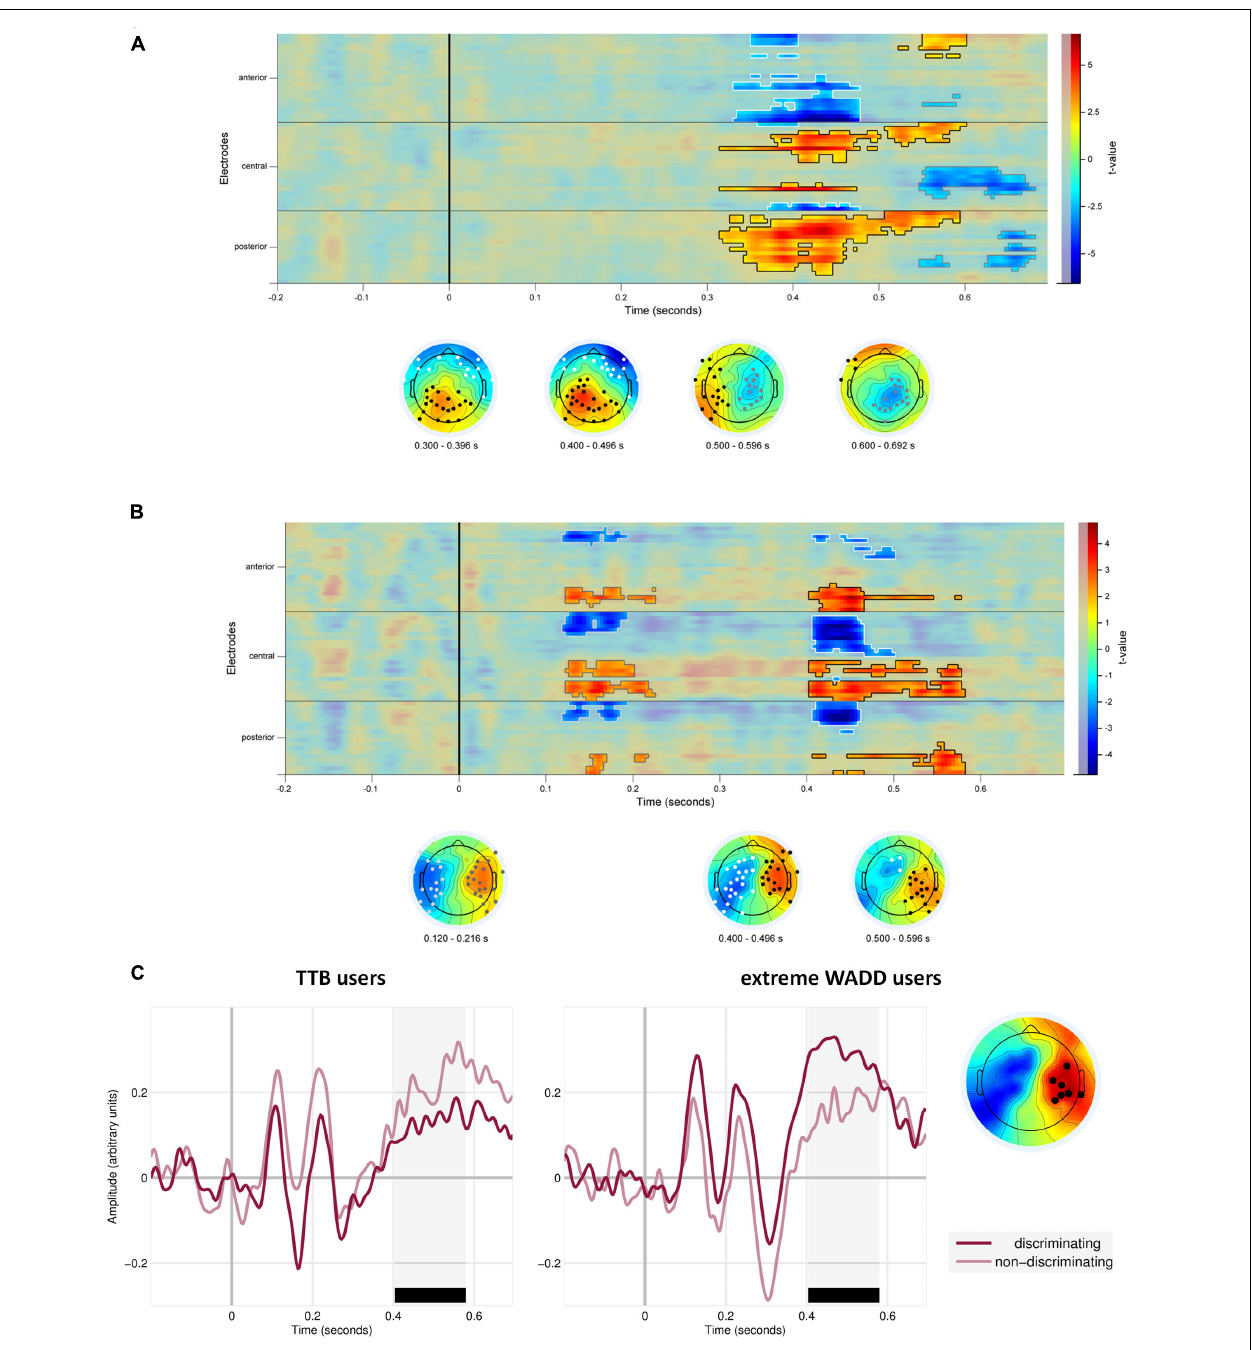
FIGURE 5 | (A) Temporal and scalp distribution of the main effect of cue discrimination. Marked in black, white and gray are the spatiotemporal clusters where the EEG amplitude differed for the discriminating and non-discriminating cue. (B) Temporal and scalp distribution of the interaction effect of discriminative value and strategy preference. (C) ERPs to the discriminating and non-discriminating cues plotted for TTB users, and extreme WADD users. The time window where the effects in the P3 range were observed is marked in